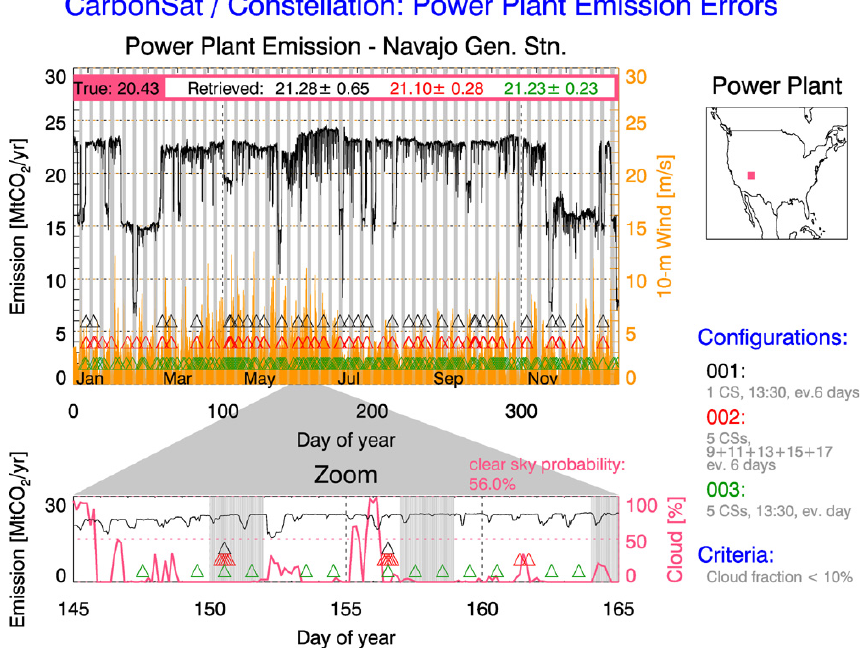
Fig. 6. Top panel: CO 2 emissions of a power plant in Arizona, USA (Navajo generating station) reported to the EPA for 2008 (black lines). The color-coded triangles represent simulated overpasses for three different CarbonSat configurations (001–003, see Table 1) during clear sky conditions (defined as less than 10% cloud cover in a 32 × 32km area near the position of the power plant and its surroundings). Weekends are indicated by the gray shaded areas. The second y-axis represent the wind speeds (yellow, superimposed). The “true” value of 20.43 (in MtCO 2 yr − 1 ) is simply the sum of the reported CO 2 for this year. The “retrieved” values of 21.28, 21.10, 21.23 and the corresponding 1- σ errors (in MtCO 2 yr − 1 ) are the values that would have been retrieved for CarbonSat configurations 001, 002 and 003, respectively. For clarity, days 145 to 165 are zoomed in (lower panel) showing the cloud cover (in %, pink